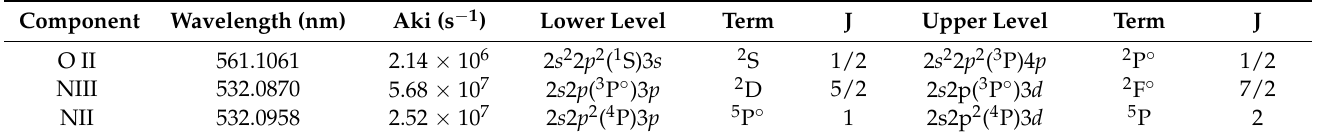
Table 2. Dipole transitions of excited oxygen and nitrogen ions falling within the emission bands of the lasers.